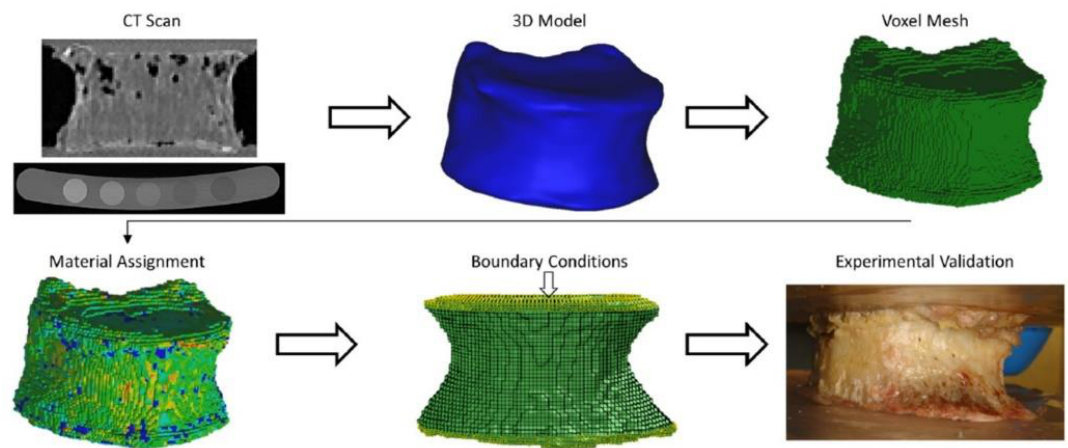
Figure 14. Overview of process steps to perform a finite element method (FEM) analysis from a CT scan (reproduced with permission from [77], Elsevier, 2018).